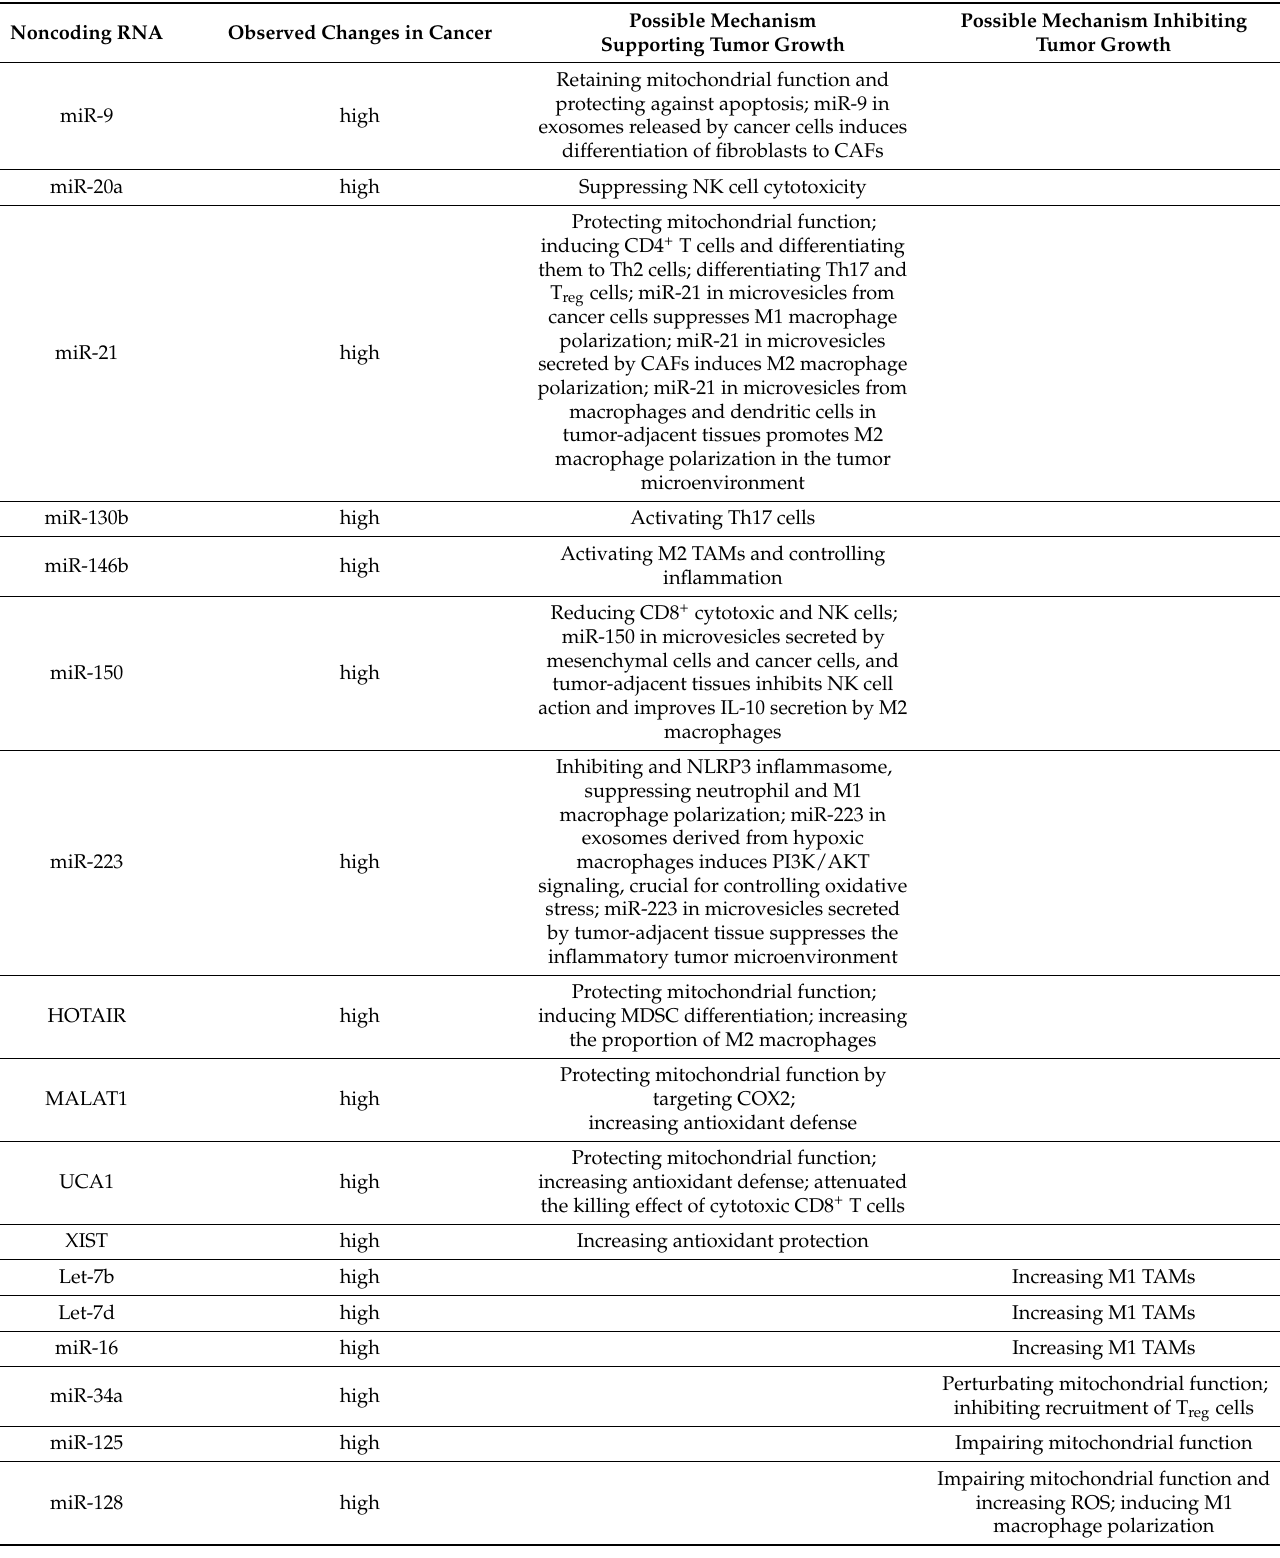
Table 1. Overview of expected effects of changes in expression of noncoding